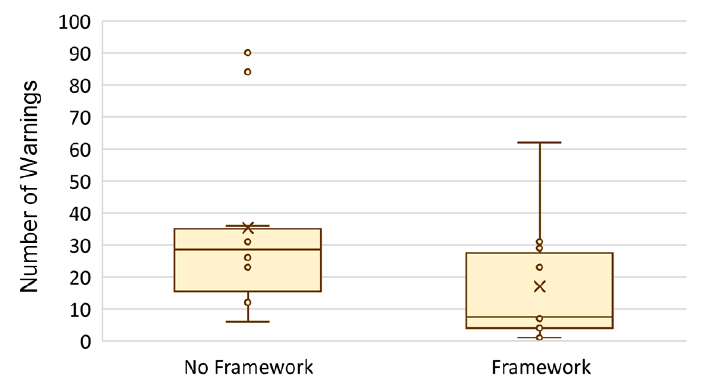
Figure 18. Summary of compiler warnings during development. Average of 35.3 warnings without the framework and 17.0 warnings with the